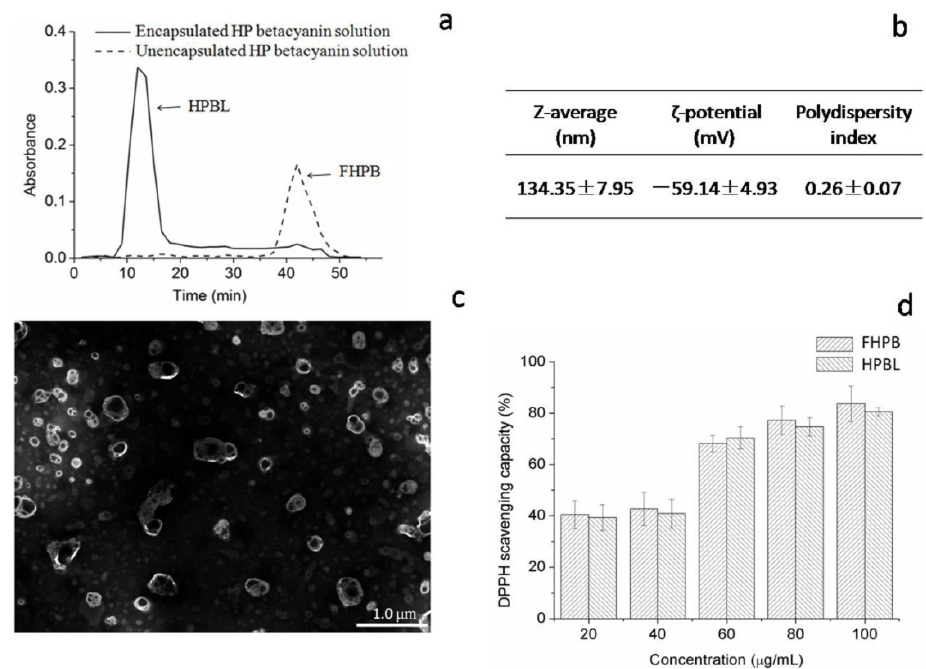
Figure 2. Physicochemical characteristics of HPBL: ( a ) Absorbance of encapsulated HP betacyanin solution and unencapsulated HP betacyanin (FHPB) solution with a wavelength of 538 nm as separated by Sephadex G-50; ( b ) size(z-average), ζ -potential, and polydispersity of HPBL;( c ) transmission electron microscopy observation of HPBL; ( d ) DPPH free radical scavenging rate.